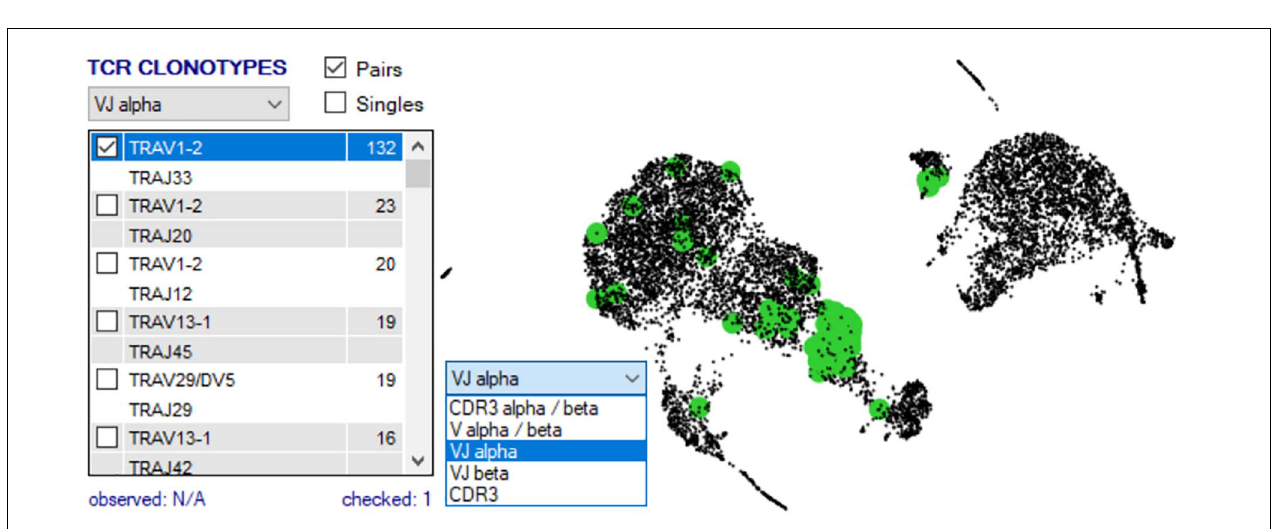
FIGURE 7 | scRNA-defined UMAP overlay of scTCR-seq. Single-cell defined functional TCR clonotypes can be imported for selected populations/samples, displayed in order of dominance within the Plot View Options window, and highlighted on the scRNA-defined UMAP to pinpoint clusters with expression of dominant or interest TCR (highlighted